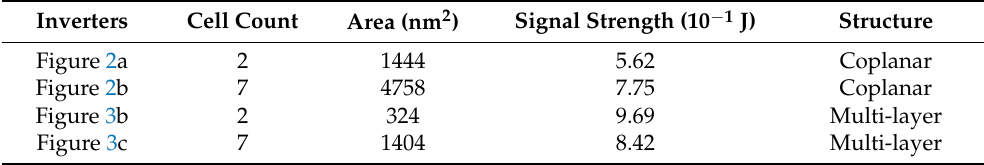
Table 1. Performance comparison of coplanar inverter and multi-layer inverter. Inverters Table 2. Truth table of 2-to-1